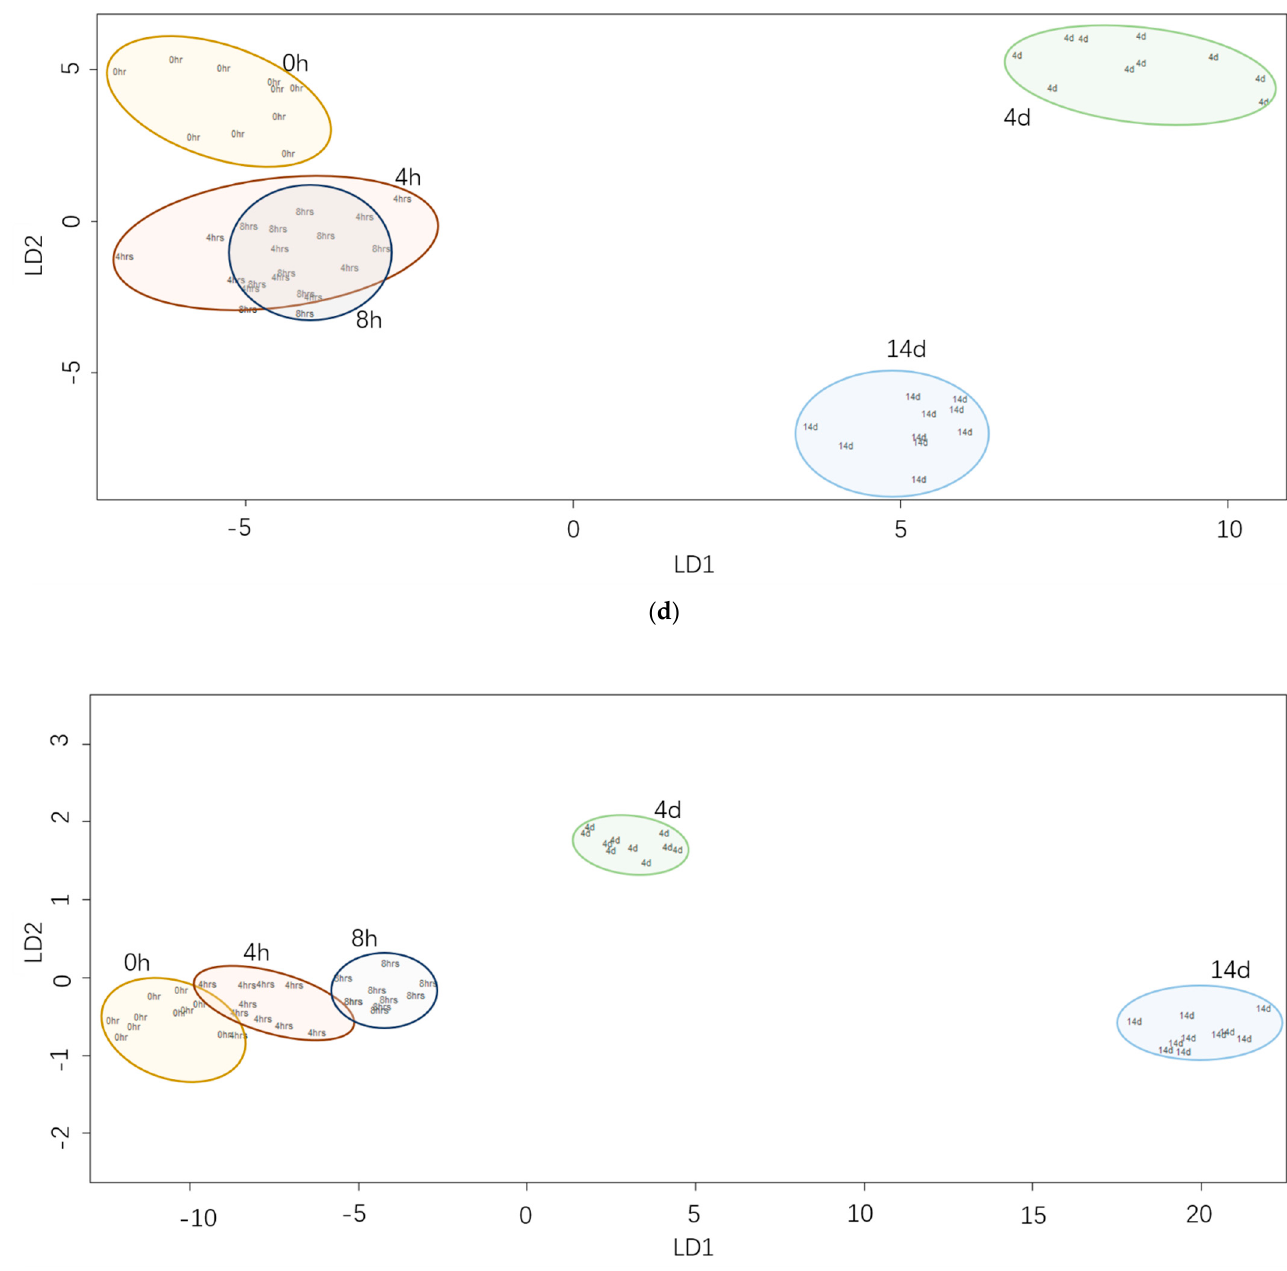
Figure 6. Score plots of discriminant analysis. ( a , b ), discriminant score plots for the five sample solutions at 0 h and 14 d of storage, respectively. ( c – e ), discriminant score plots for tap water, TMW − SIE and AlEW − SIW solutions during storage (0 h–14 d), respectively. AlEW, alkaline electro ‐ lyzed water; TMW, tourmaline water; AlEW/TMW − SIW − 4mA, silver − ionized water produced by water; TMW, tourmaline water; AlEW/TMW-SIW-4mA, silver-ionized water produced by using AlEW or TMW as electrolyte at 4 mA. All sample solutions in this study contained 2 mmol/L AsA.